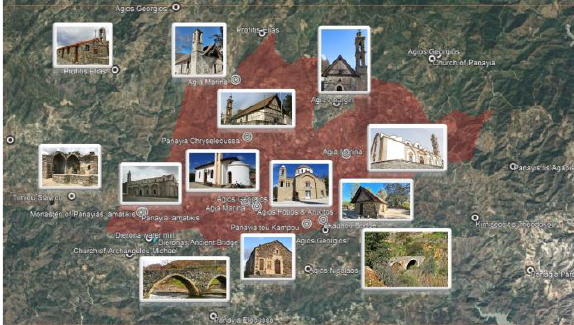
Figure 1 The 22 cultural heritage sites in the extended region of the fire